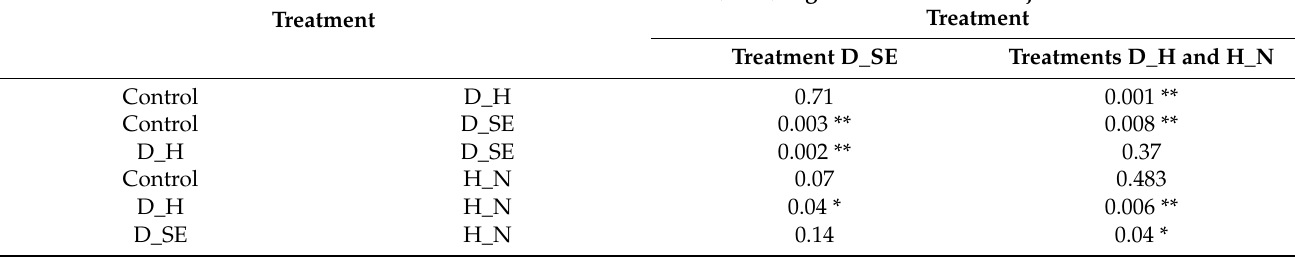
Figure 7. Surface temperature of plants under different treatments, (control, drought at stem elongation (D-SE), drought at heading (D-HD), and high nitrogen content (H-N)). The X -axis represents the treatments and the Y -axis represents the mean temperature values obtained with QGIS software. Statistically significant differences (Tukey’s HSD *** p < 0.001, ** p < 0.01 and * p < 0.05) are denoted by the stars above the bars. Error bars are standard error. Temperature measurements ( A ) after five days of inducing drought stress at stem elongation, D_SE and ( B ) after five days of inducing drought stress at heading, D_HD, and second dosage of liquid nitrogen fertilizer was applied, H-N. ( C ) Temperature measurements when all plants were irrigated. Table 2. Differences among the four treated plant groups after treatment effect: drought at stem elongation (D_SE), drought at heading (D_H), and high nitrogen (H_N). Significant differences marked with asterisk (* p < 0.05, ** p < 0.01). Pr(>|t|) Significant Value of Projected Green Area Treatment